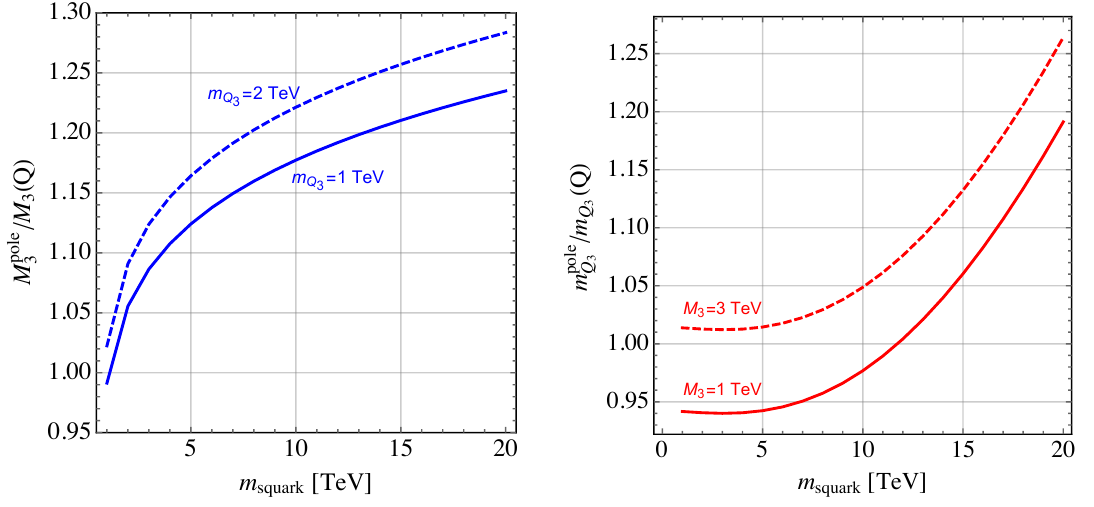
Figure 5 . Left: ratio of gluino pole mass to running IR mass (at Q = 1 TeV), with M 3 ( Q ) = 1 : 5 TeV, as a function of the common 1st/2nd generation squark mass m squark , for two di(cid:11)erent choices of the 3rd generation squark mass. Right: ratio of the stop pole mass to running IR mass (at Q = 1 TeV), with m Q ( Q ) = m U ( Q ) = 1 : 5 TeV, as a function m squark , for two di(cid:11)erent choices 3 3 of the gluino